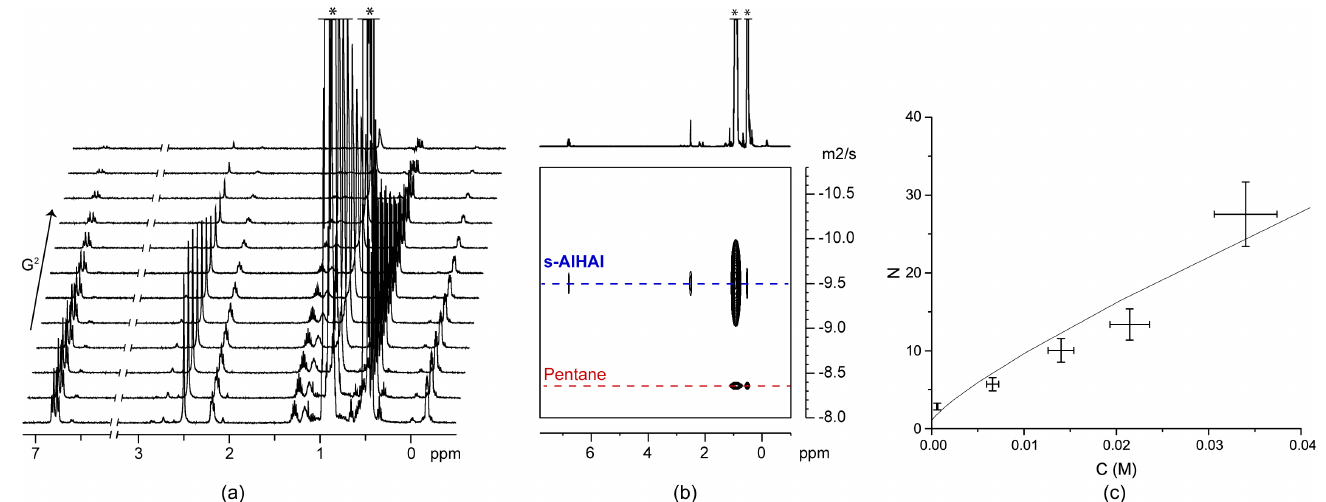
Figure 2. ( a ) Representative 1D diffusion NMR spectra of s-AlHAl at increasing gradient strength in pentane (with acetone- d 6 coaxial capillary, 298 K, 33 mM) and ( b ) DOSY map derived therefrom; ( c ) trend of the average aggregation number ( N ) as a function of the analytical concentration of s-AlHAl derived from diffusion NMR measurements (trendline obtained by fitting experimental data based on the IK model; see ESI). *, solvent signals. A 15% and 10% error are assumed on aggregation number and concentration, respectively [43,44].